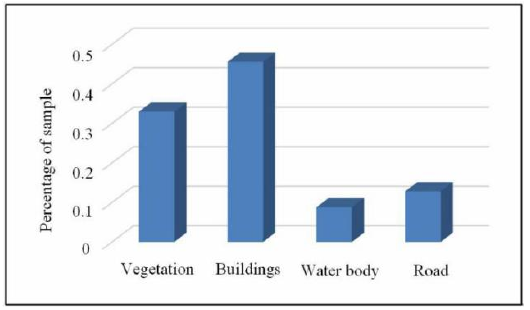
Figure 8. Different categories of sample statistics in the data set . Figure 8. Di ff erent categories of sample statistics in the data